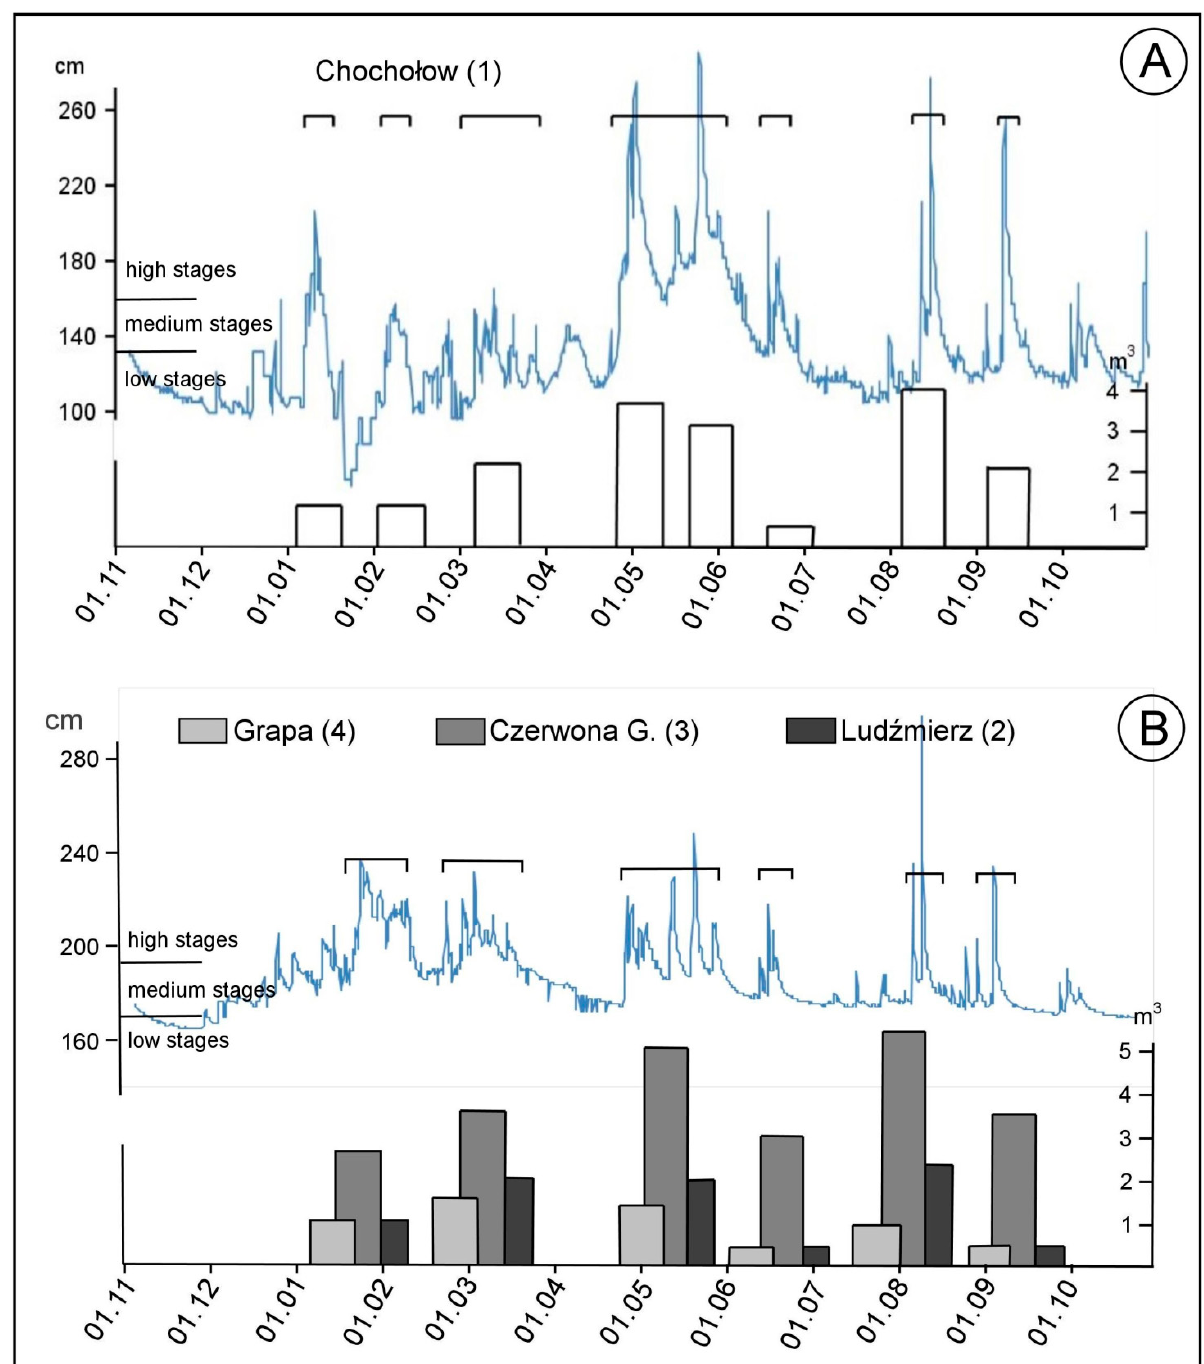
Figure 15. Relations between volumes of eroded colluvium (columns) and water levels (curve) on the Czarny Dunajec ( A ) and Wielki Rogo ź nik ( B ) rivers in 2019; the interval of high water levels is marked with horizontal line and brackets mark the distinguished phases of colluvium erosion.